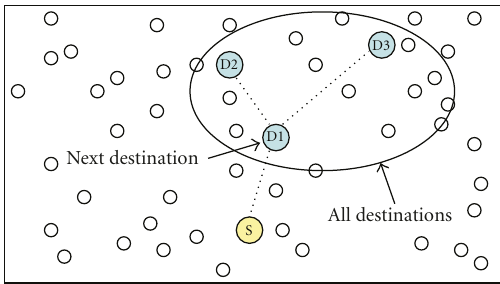
Figure 3: Next Destination and All Destinations in LBM-MST.